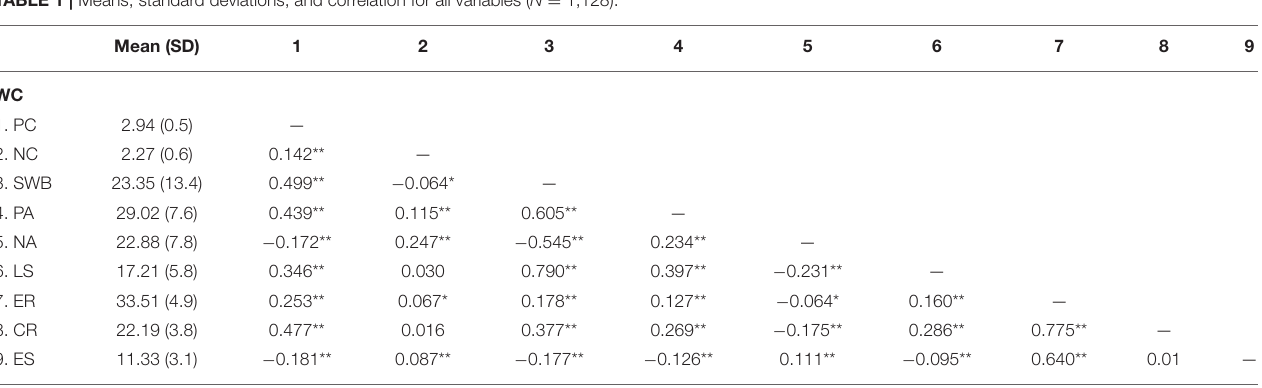
TABLE 1 | Means, standard deviations, and correlation for all variables ( N = 1,128).